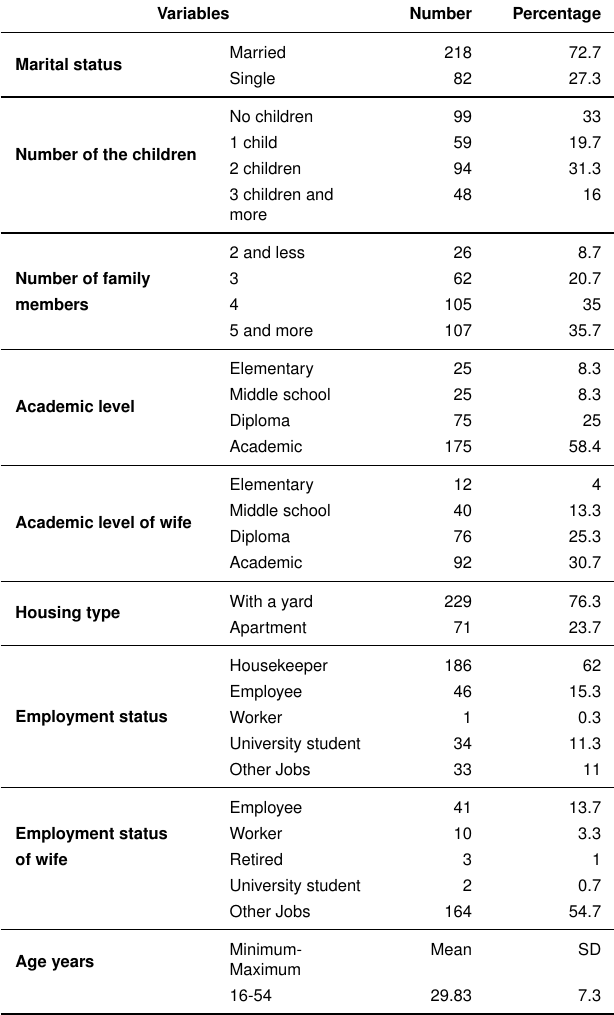
Table 2. Analysis of annual rainfall variability for 1981 to